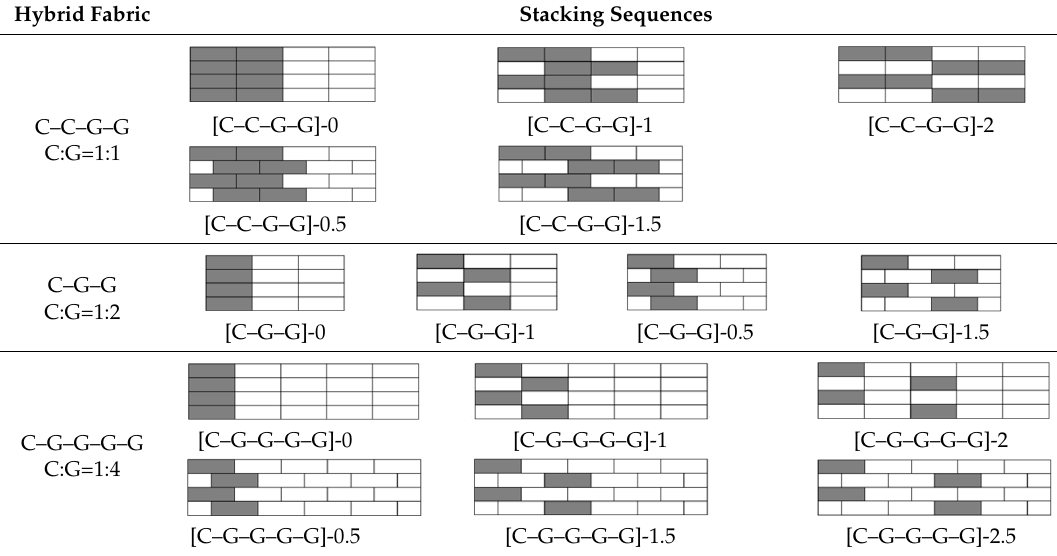
Table 4. Stacking configurations of intralayer hybrid structures.